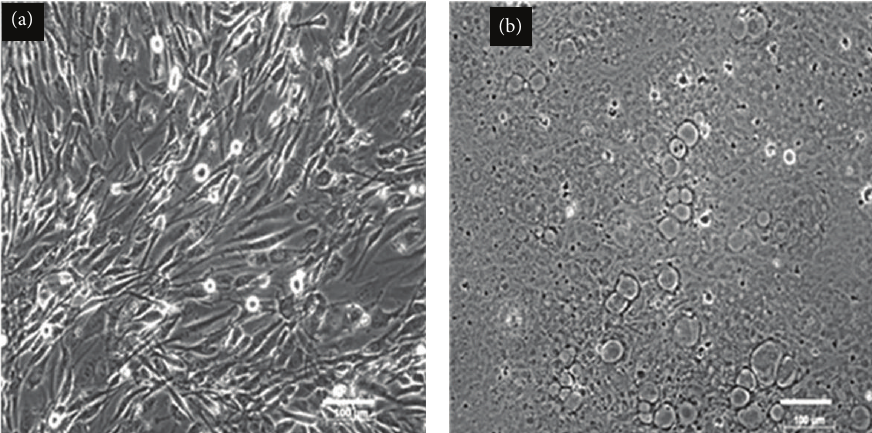
Figure 2: Phase contrast microscope images of HS-5 stromal cells (a) before decellularization and (b) after decellularization (scale bar: 100 𝜇 m).